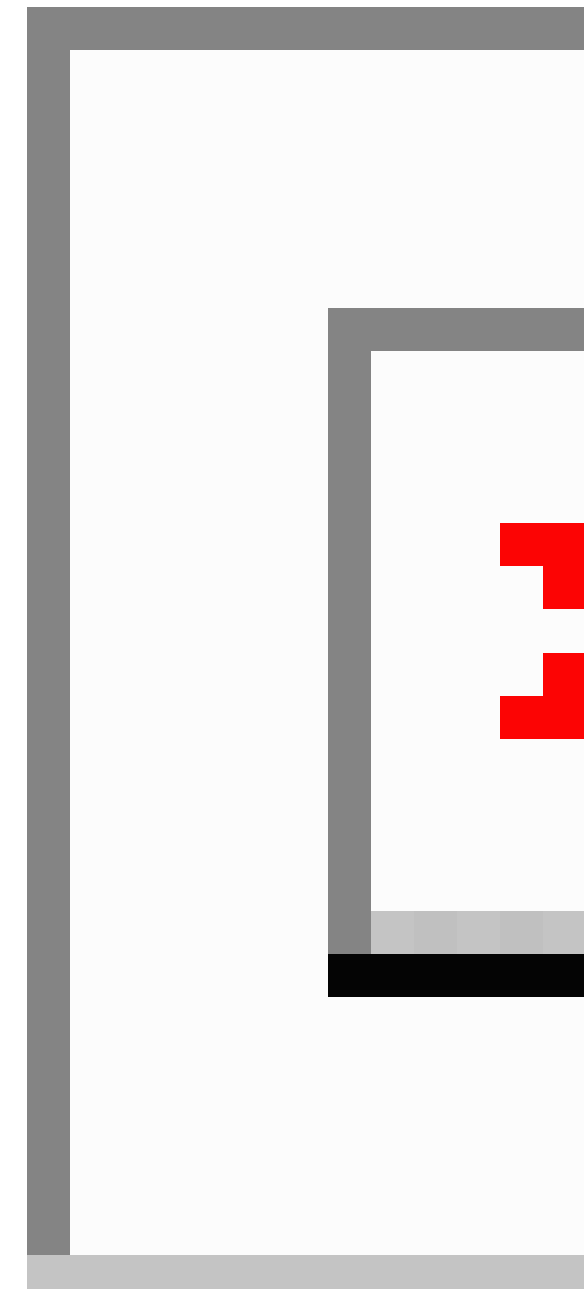
Figure 1. Modified bathroom